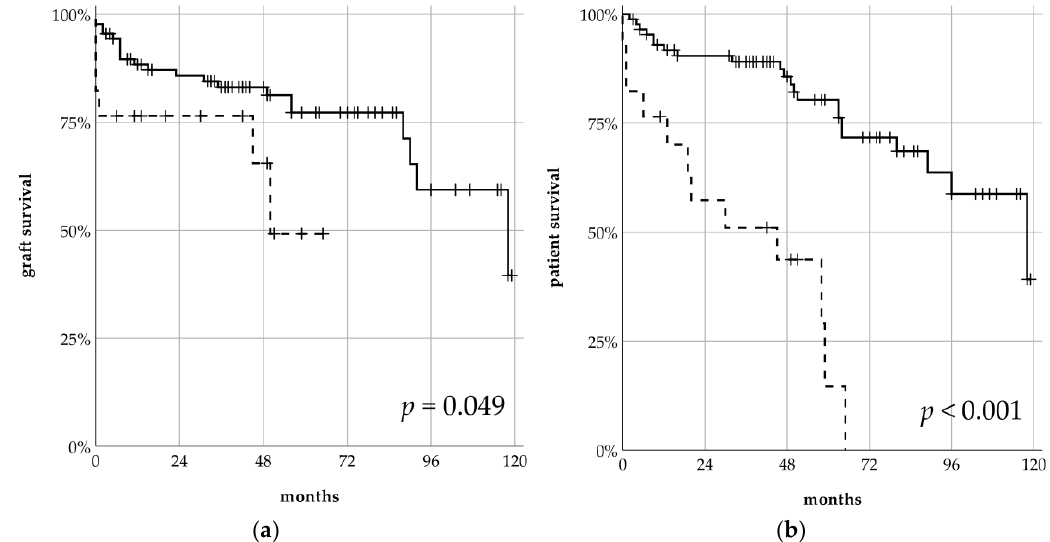
Figure 2. Death-censored graft survival ( a ) and patient survival ( b ) comparing patients admitted to the ICU ( dashed line ) vs. patients not admitted to the ICU ( solid line ) after kidney transplantation in the ESP program.